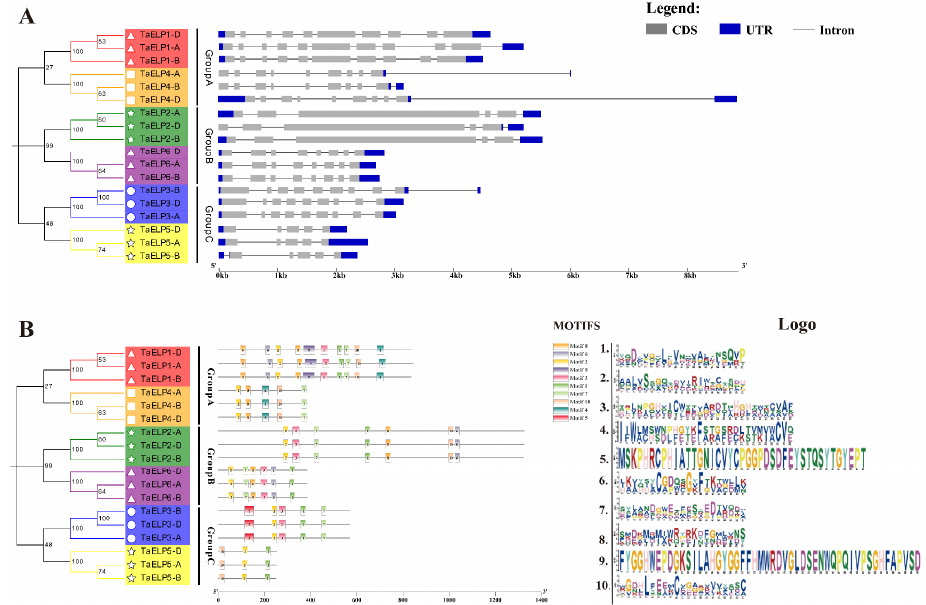
Figure 4. Gene structure and motif analysis of TaELPs . ( A ) Introns are represented with black lines, exons are represented with gray boxes, and untranslated regions (UTRs) are represented with blue boxes. ( B ) Conserved motifs of members of TaELPs . Ten patterns were identified using the MEME program and are presented with boxes of different colors. Legend: Represents gene structure. Logo: Indicates different MOTIFS patterns.